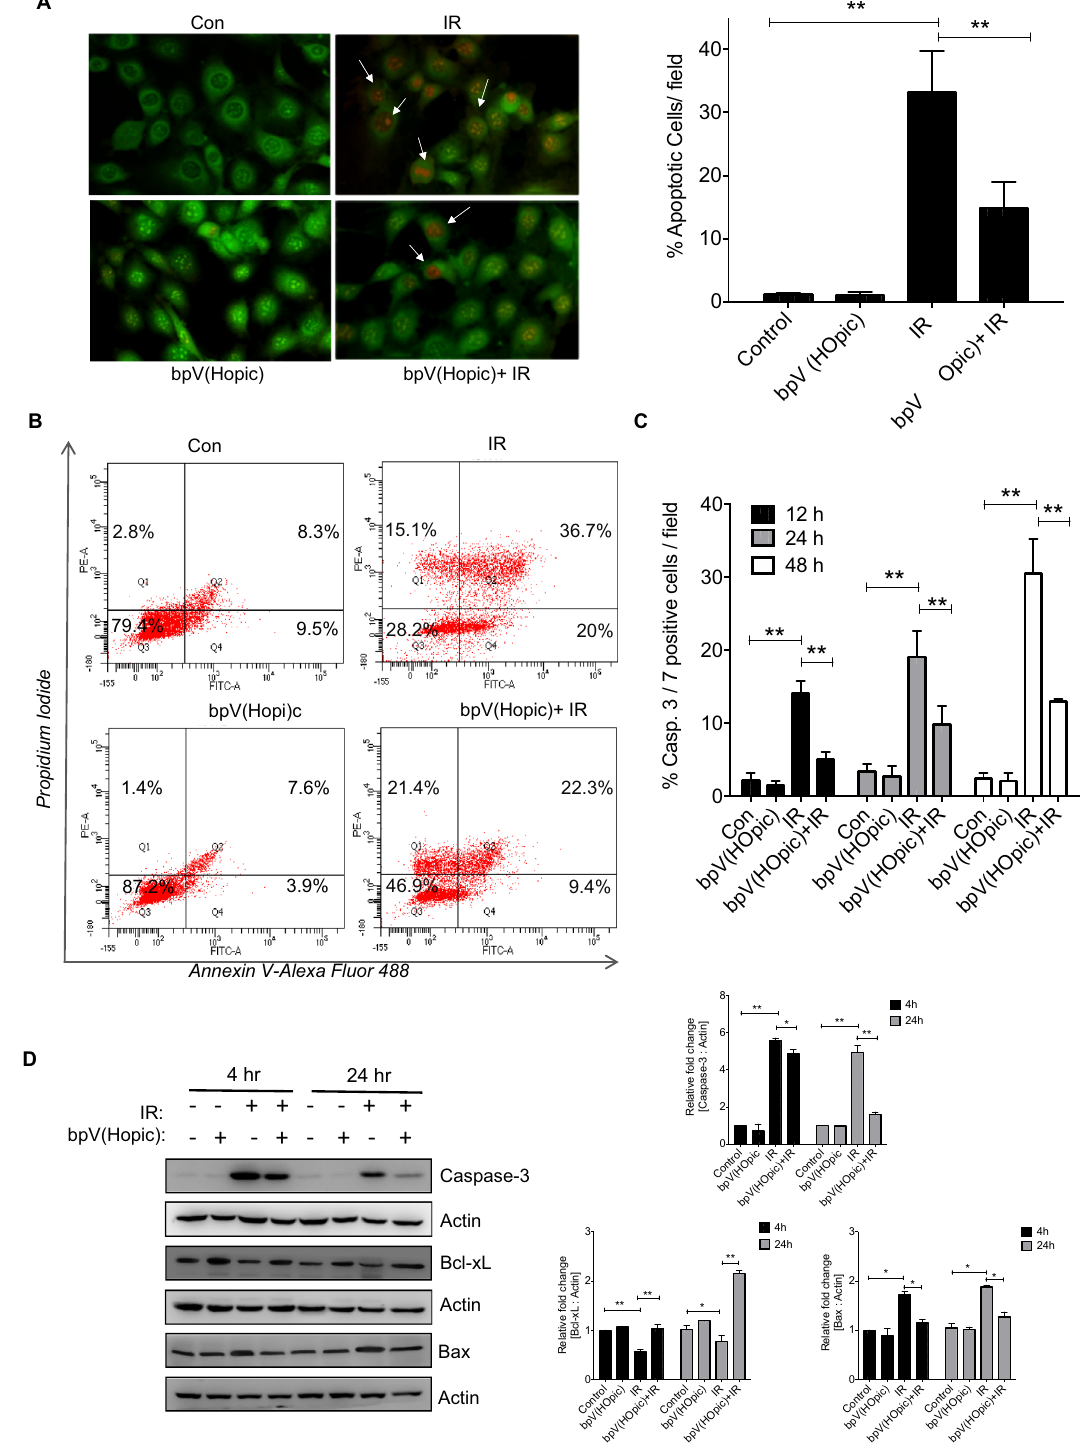
Figure 2. bpV(HOpic) pretreatment ameliorates radiation induced cell death. ( A ) Representative photomicrograph of AO/EtBr stained NIH-3T3 pretreated with 100 nmol/L of bpV(HOpic), 48 h post irradiation. Barcharts represents % of total EtBr positive cells per field. ( B ) Representative flow cytometry scatterplots depicting Annexin-V (Alexa Fluor 488)/Propidium Iodide staining of NIH-3T3 cells after 100 nmol/L bpV(HOpic) pretreatment and irradiation (48 h post 4 Gy IR exposure). Quadrants (Q1–Q4) represents retention of different apoptotic phase events (%). The percentages of cells indicated in each quadrant as the means ± SD (n = 4) from two independent experiments. ( C ) Caspase-3/7 activity in NIH-3T3 cells pretreated with bpV(HOpic) one hour prior to 4 Gy IR exposure assessed at at indicated time intervals using CellEvent probe and % of total Caspase-3/7 positive cells per field are represented as bar charts. Error bars are mean ± SD (n = 4) from two independent experiments. * p < 0.05; ** p < 0.01. ( D ) NIH-3T3 cells were pretreated with bpV(HOpic) 1 h before irradiation and whole cell lysates at indicated timepoints were subjected to immunoblotting for key pro-apototic and pro-survival proteins. Fold change in protein levels with respect untreated control is represented with densitometry plots expressed as mean ± SD. * p < 0.05; ** p <